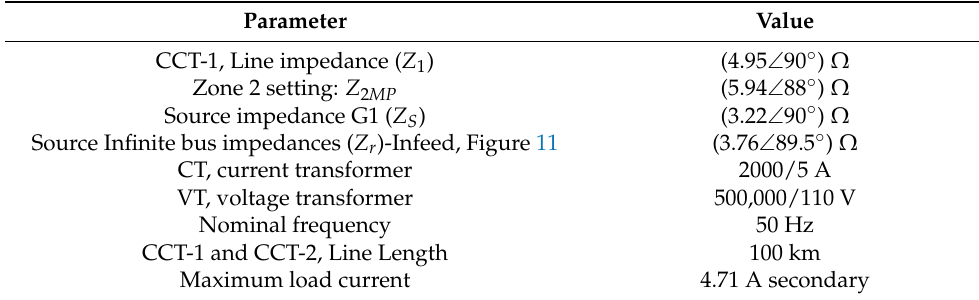
Table 1. Two sources power system